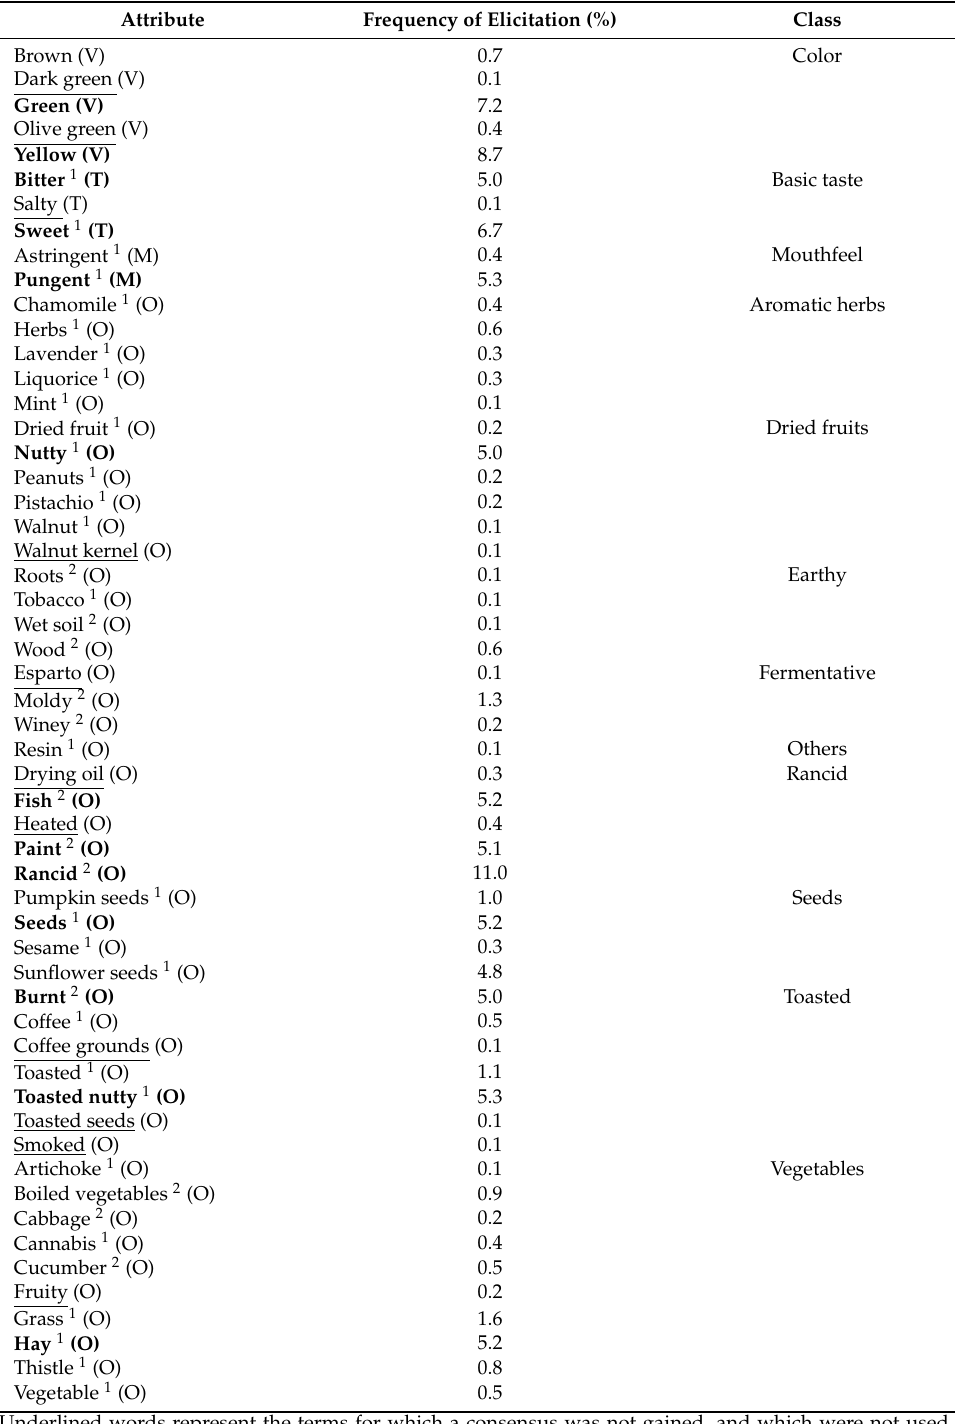
Table 2. Sensory attributes in alphabetic order generated through the language development